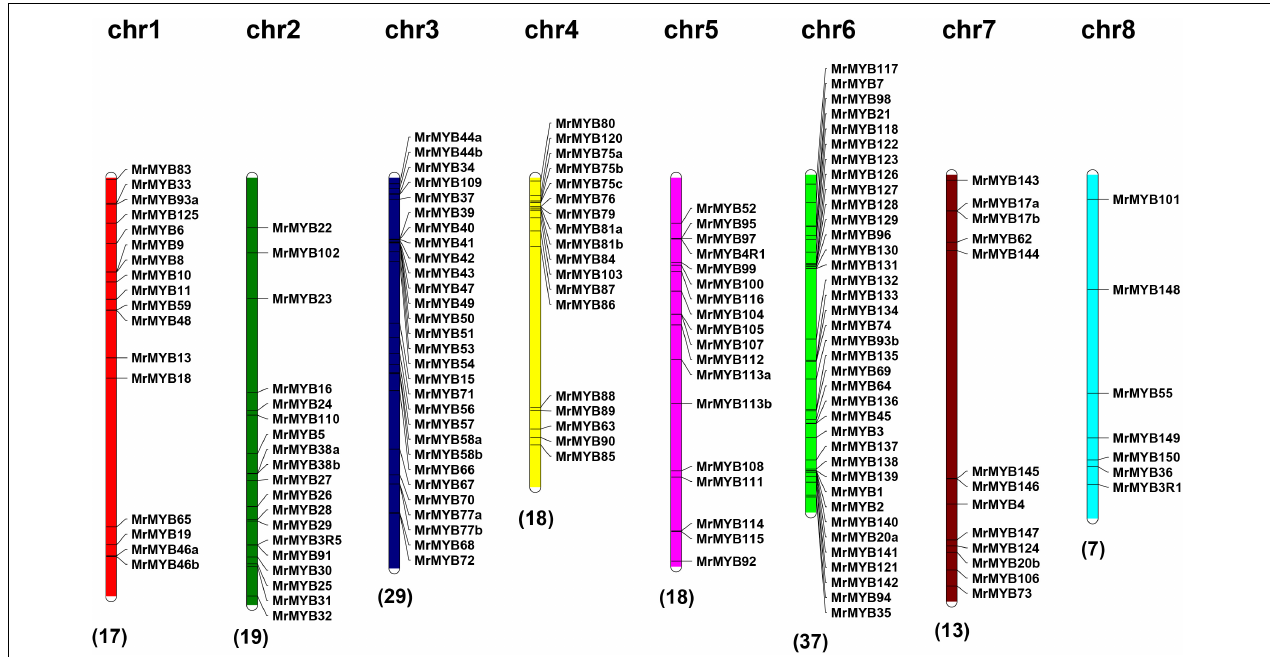
FIGURE 3 | Chromosome distribution of MrMYB genes. The chromosome numbers are shown at the top of each chromosome, and the number of MrMYB genes in each chromosome is shown at the bottom of each